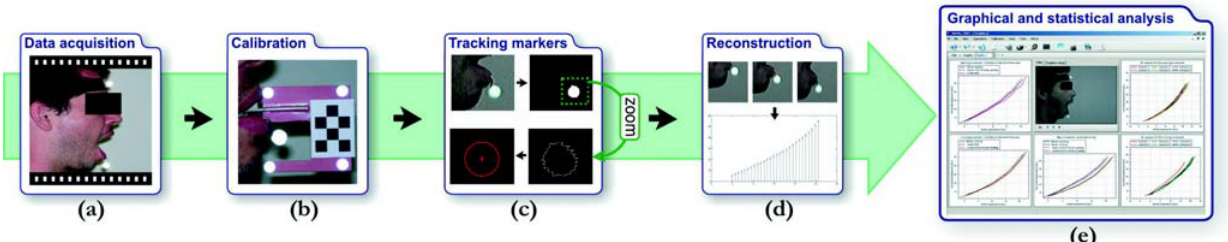
FIGURE 3- Schematic diagram for data processing. (a) Video acquisition with the markers; (b) calibration using the calibration object; (c) tracking the markers on each video frame; (d) reconstruction of the marker’s coordinates and smoothing of movement traced (noise removal); (e) graphical and statistical analyses of the movement